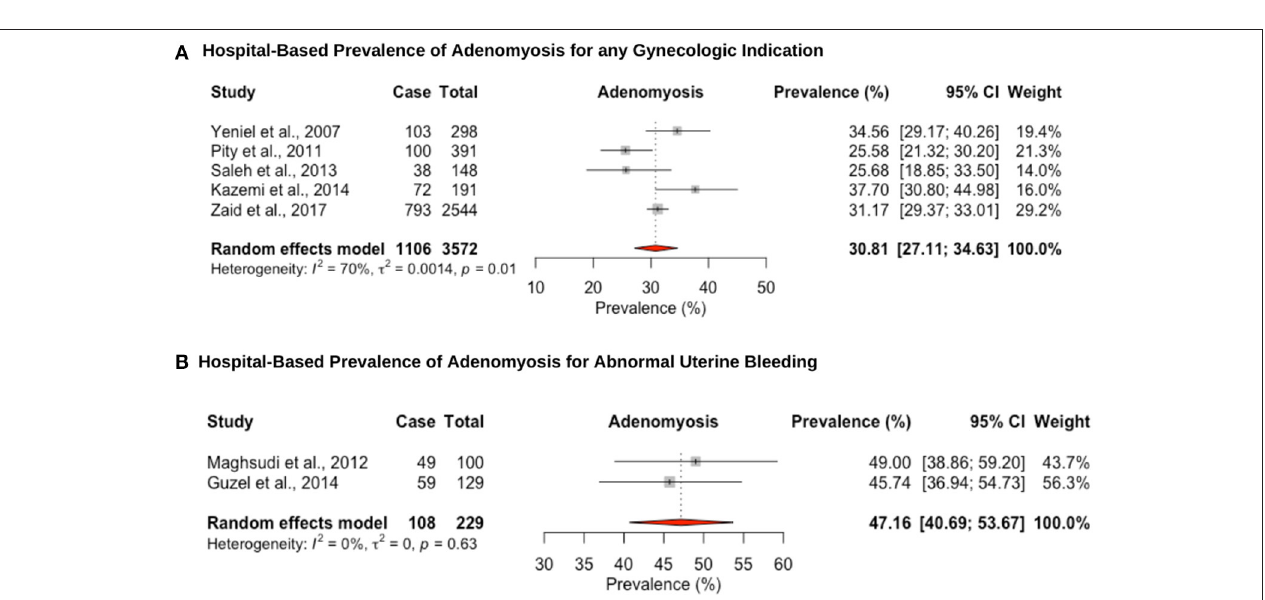
FIGURE 5 | Forest plot of the pooled prevalence estimate of hysterectomy-confirmed adenomyosis: (A) hospital-based study (undergoing hysteroscopy in a period of time) and (B) hospital-based study (presenting with abnormal uterine bleeding).